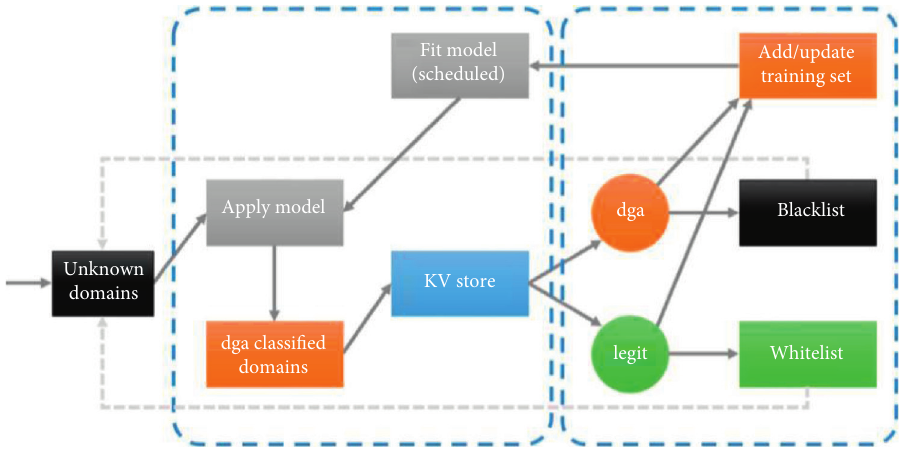
Figure 24: Classification and analysis of DGA